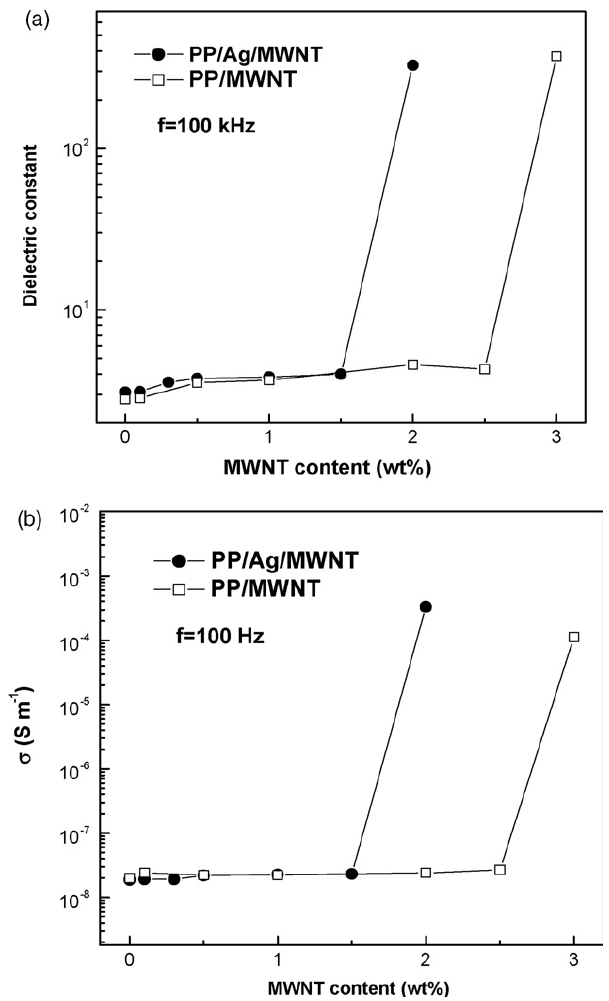
Figure 30. Variations of (a) dielectric constant and (b) conductivity with MWNT content for PP/MWNT and PP/Ag/MWNT nanocomposites. The nano-Ag content is fixed at 10 wt % for PP/Ag/MWNT hybrid nanocomposites. Reproduced with permission from ref.